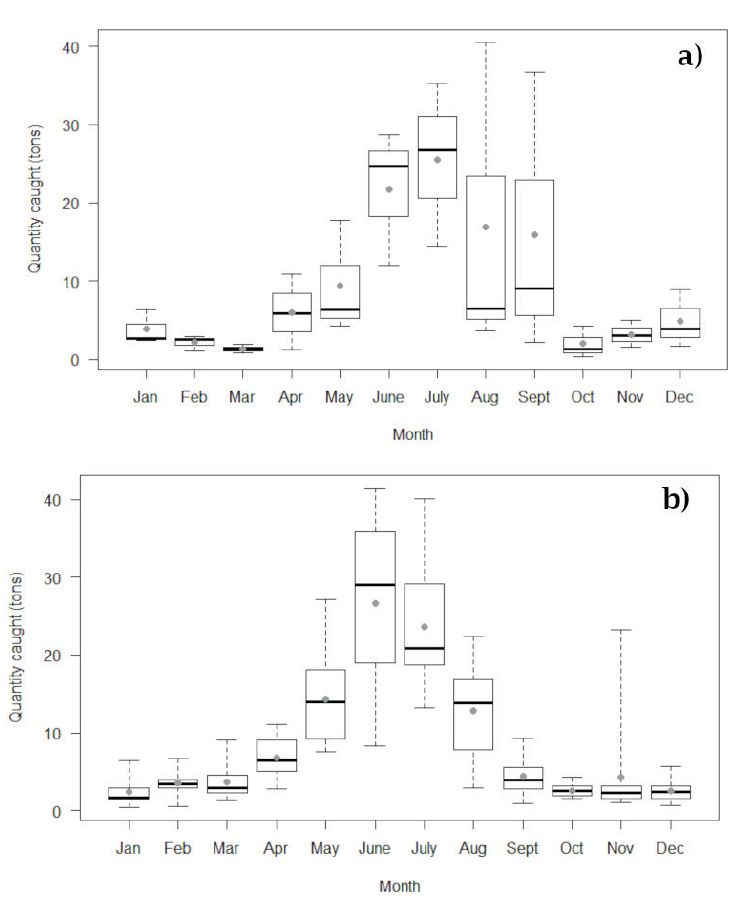
Figure 2. Boxplot with the production distributed throughout the year. a) refers to production in the State of Paraná (period from 2017 to 2019) and b) to production in the State of São Paulo (period from 2009 to 2019). The gray dot shows the average production for each